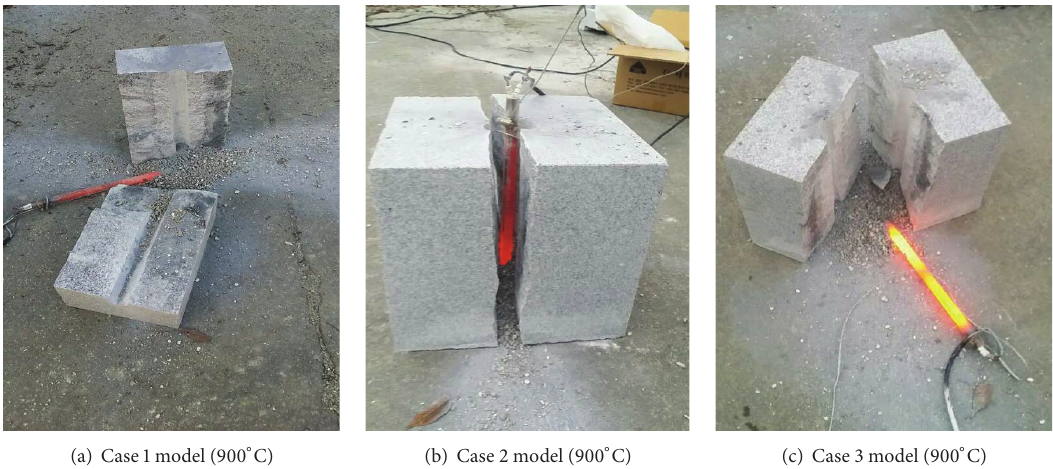
Figure 7: Final cracking (FC) images of massive granite subjected to uniform pressure.